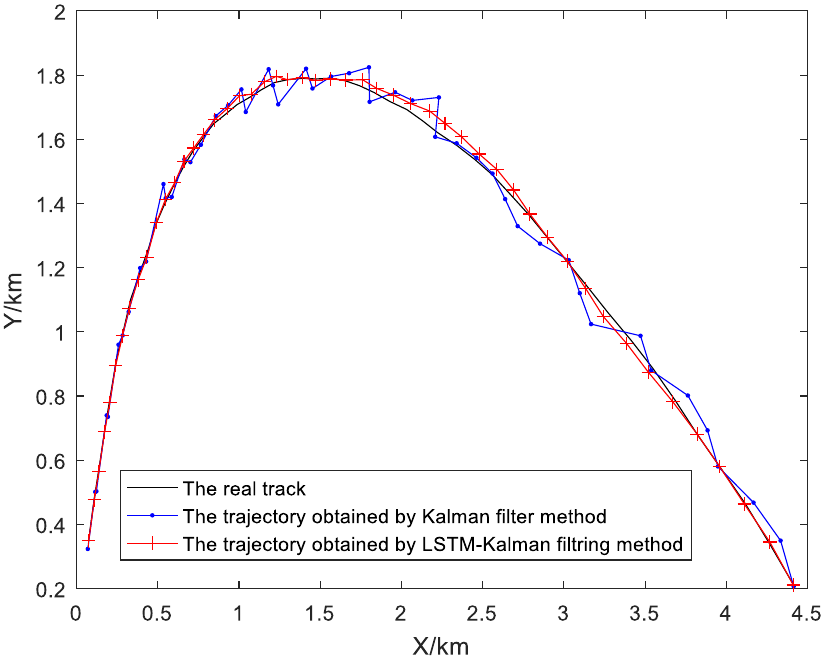
Figure 15. Comparison of the real trajectory, the tracking trajectory that was obtained using the Kalman filtering method, and the tracking trajectory that was obtained using the LSTM–Kalman filtering method.